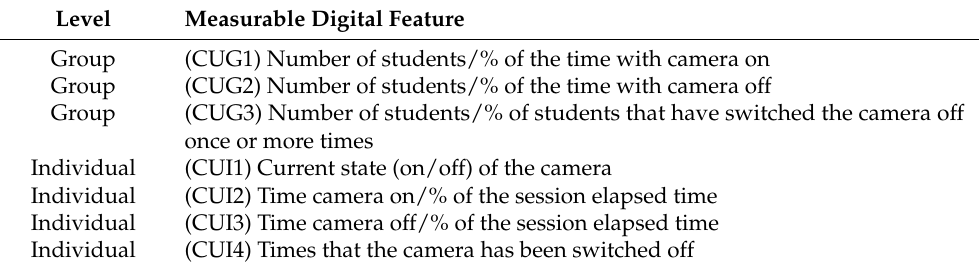
Table 8. Set of digital features defined for “camera usage” category, corresponding to features B15 and